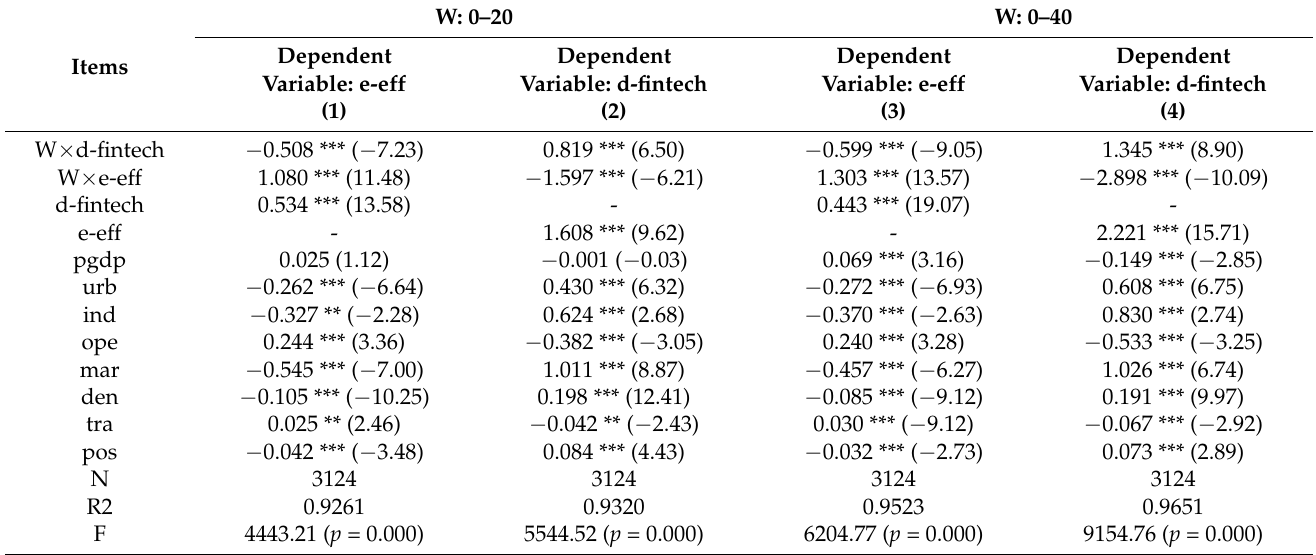
Table 6. Results of the robustness test of distance